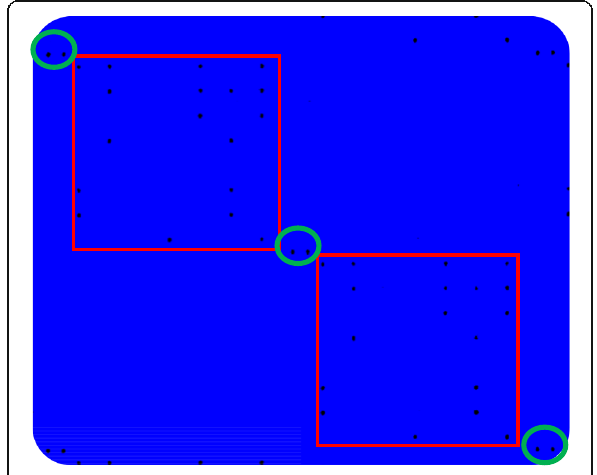
Fig. 5 The RGB mode of the regular repeated basic coded dot matrix pattern in black color of Ricoh ® SP C 430DN sample